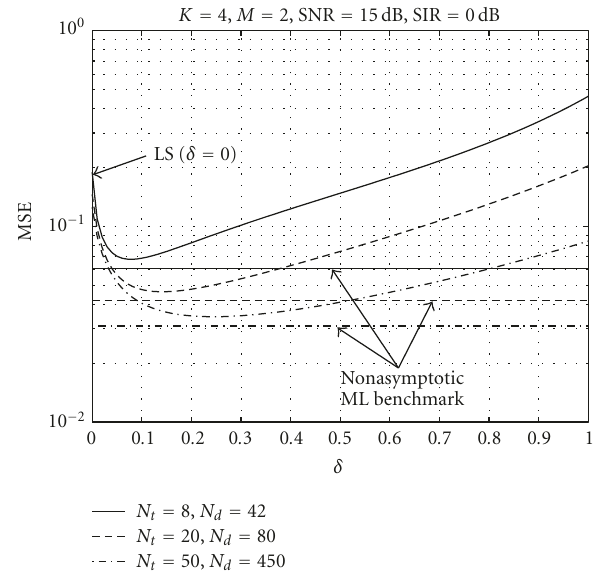
Figure 7: Typical MSE performance for the SB algorithm for vari- able regularization